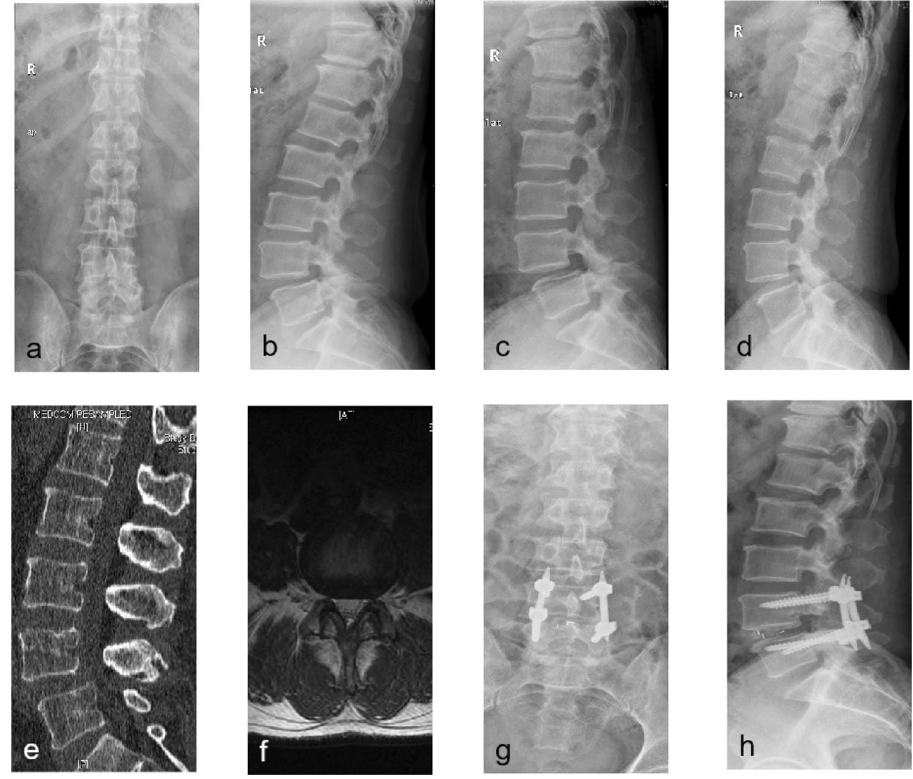
Figure 1. A 61 years old male patient who suffered from low-back pain for 16 months prior to admission underwent MIS-TLIF procedure. ( a , b ) Antero-posterior and lateral plain radiography before operation; ( c , d ) preoperative flexion and extension plain radiography indicated patient with LDS grade 1; ( e , f ) preoperative sagittal CT scan and axial T2-weighted MR image; ( g , h ) antero-posterior and lateral plain radiography after